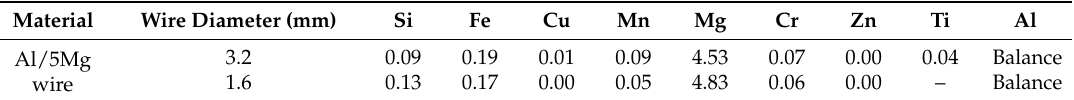
Table 1. Composition of the coating material